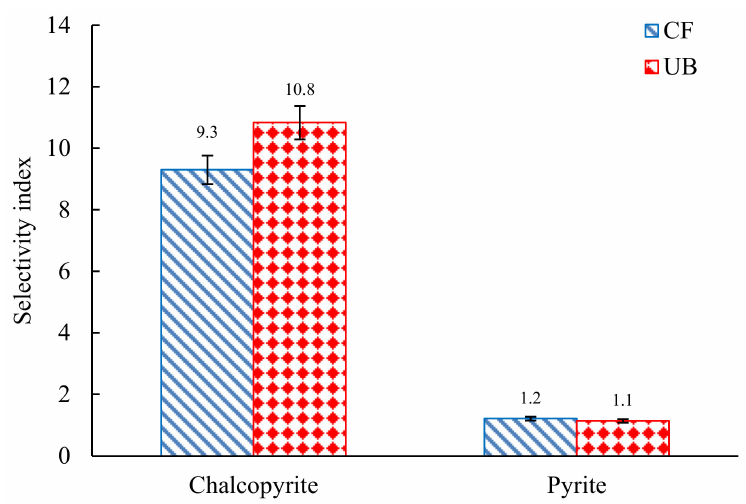
Figure 4. Selectivity indices of chalcopyrite and pyrite with and without the ultrasonic